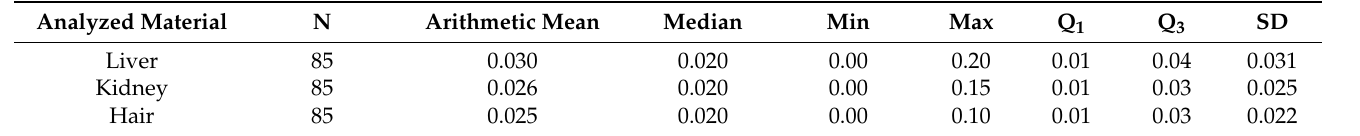
Table 1. Mercury contents in selected cat tissues in milligrams per kilogram.